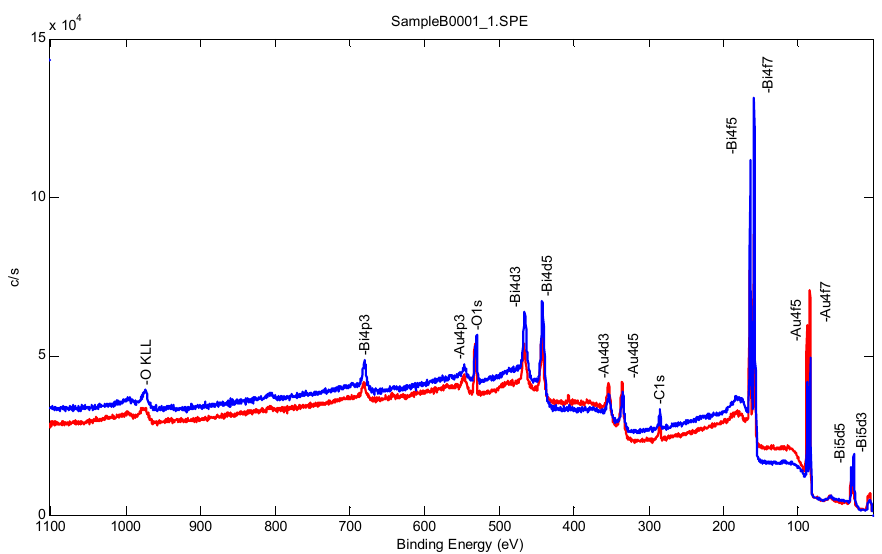
Figure 2. Survey scan from XPS measurements at 90 degrees take of angle comparing samples A (red) and B (blue). Table 1. Concentration of different elements (in Atomic Percent) compared for samples A and B. Sample No.